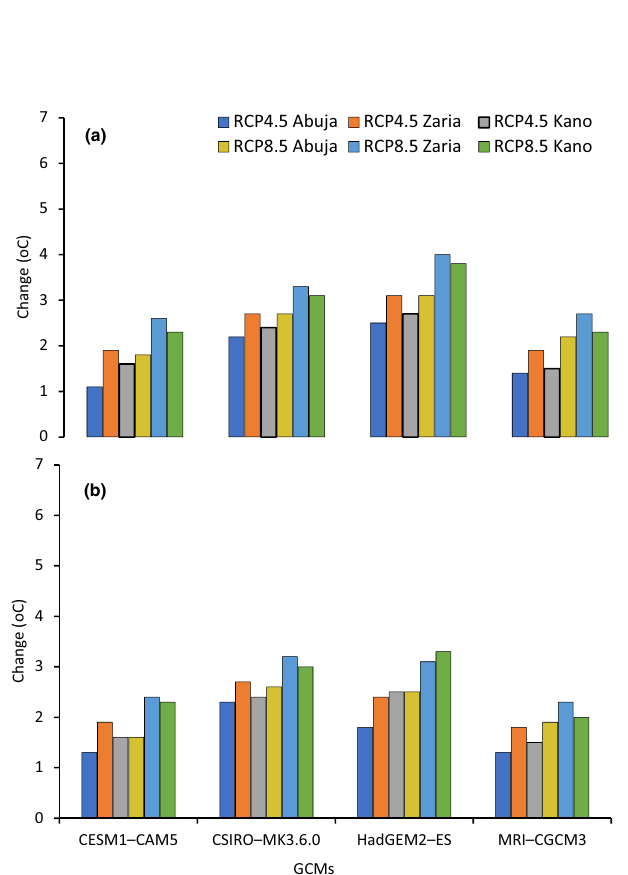
Figure 4. Minimum ( a ) and maximum ( b ) temperature change from the baseline period for four GCMs under RCP4.5 and RCP8.5 at Abuja, Zaria and Kano in Nigeria for mid-century